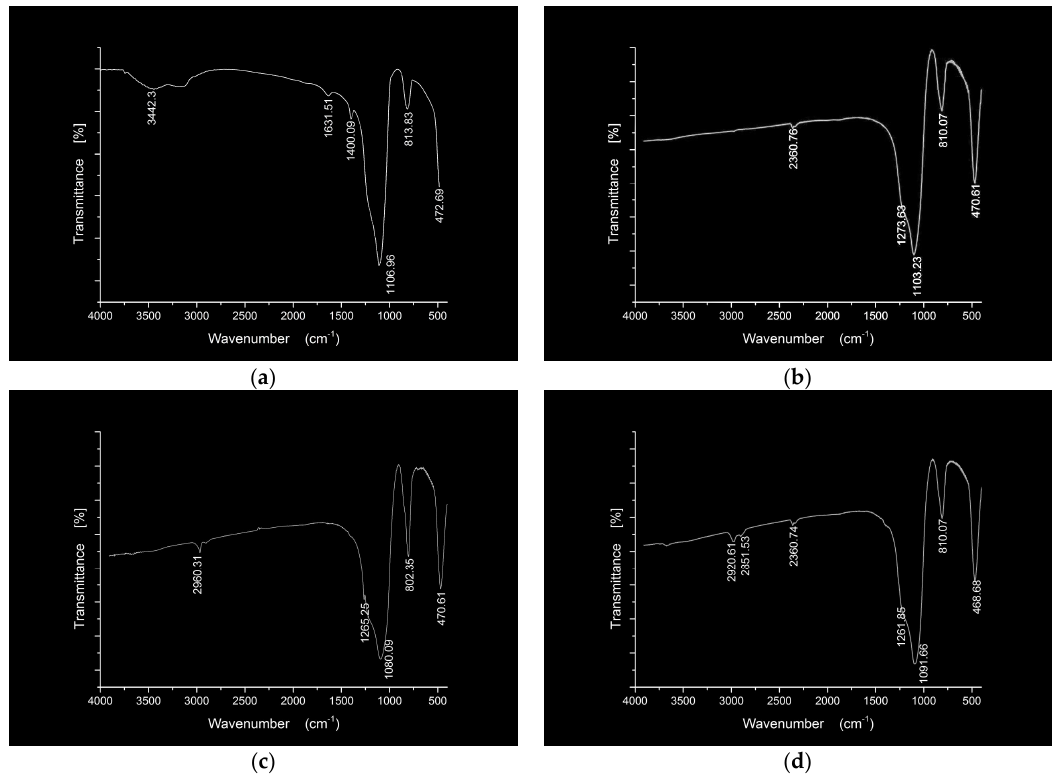
Figure 4. FTIR spectra of the nano silica and three three hydrophobic nanosilica materials. ( a ) Silica; ( b ) OCS-Silica; ( c ) SOC-Silica; ( d ) SCA-Silica.